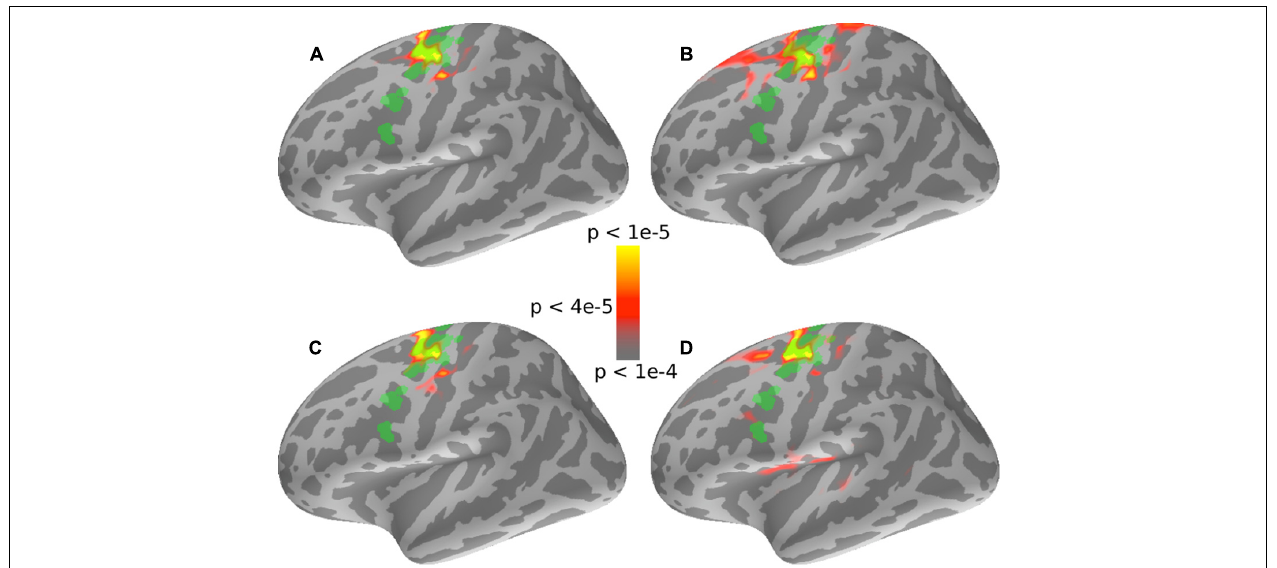
(not displayed here). The localization of the left-FEF obtained from the auxiliary saccade task is shown overlaid in green for visual comparison. (A) and (B) show 35 Hz PLV contrasts when the subjects attended to the 35 Hz stream, which was either presented in the left or the right hemifield, respectively. (C) and (D) show 45 Hz PLV contrasts when the subjects attended to the 45 Hz stream for the stream presented in the left or right hemifield,